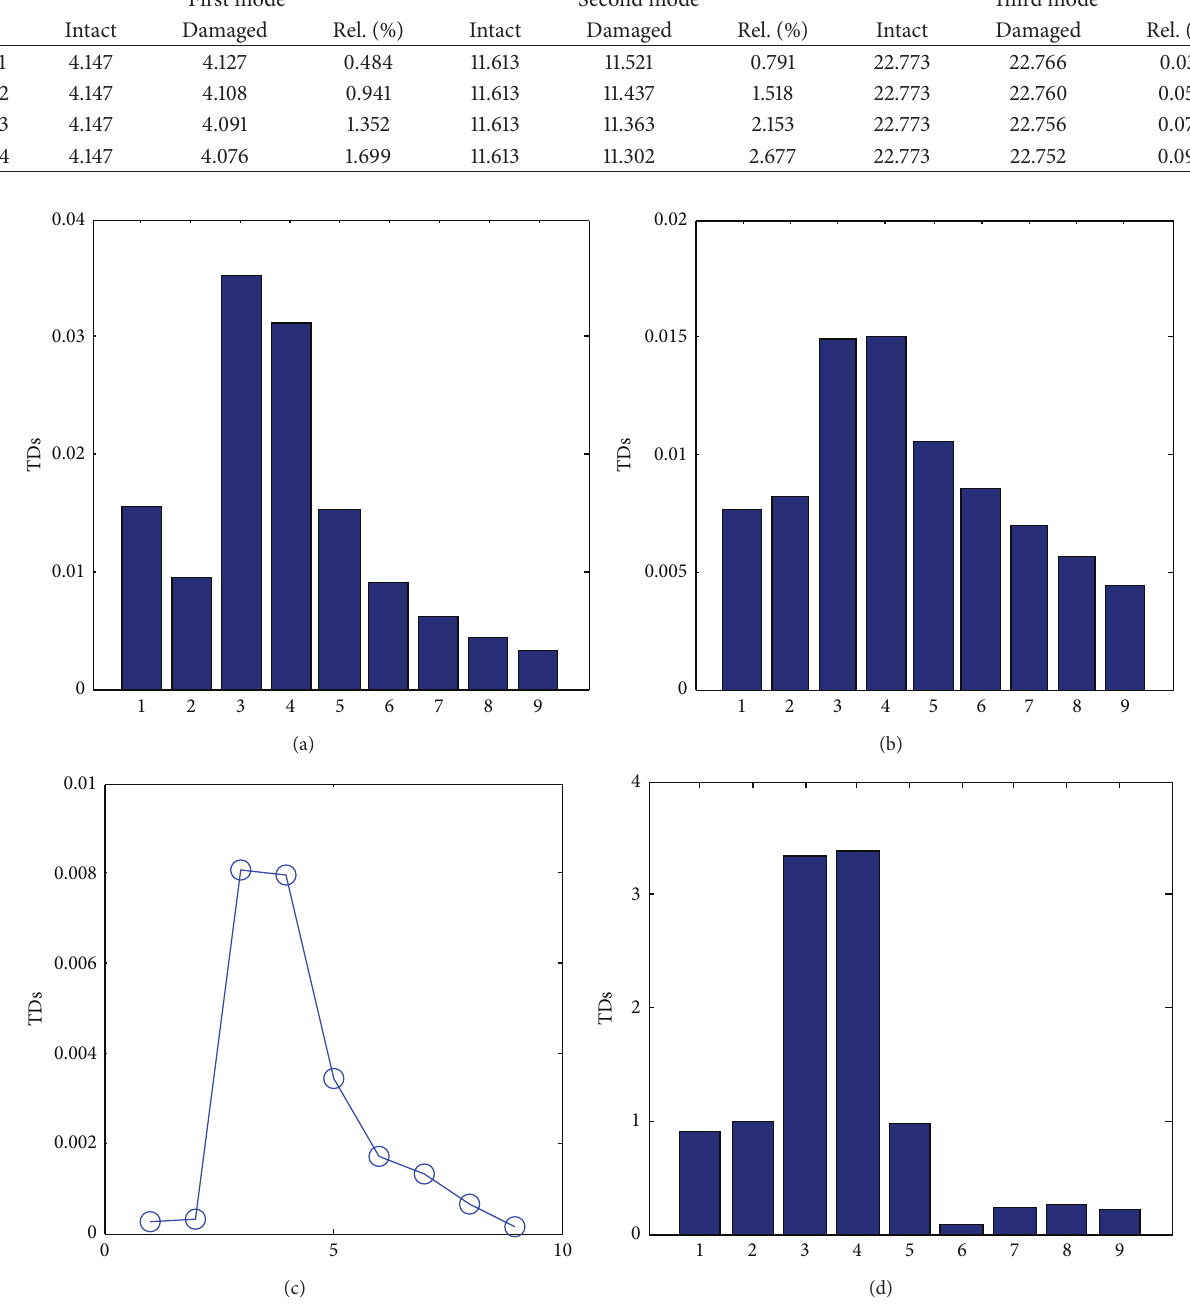
Figure 11: Detection indicators of the cantilever beam when 𝛾 = 0 . 2 with frequency band of 0–50 Hz: (a) this paper, (b) Schulz et al.